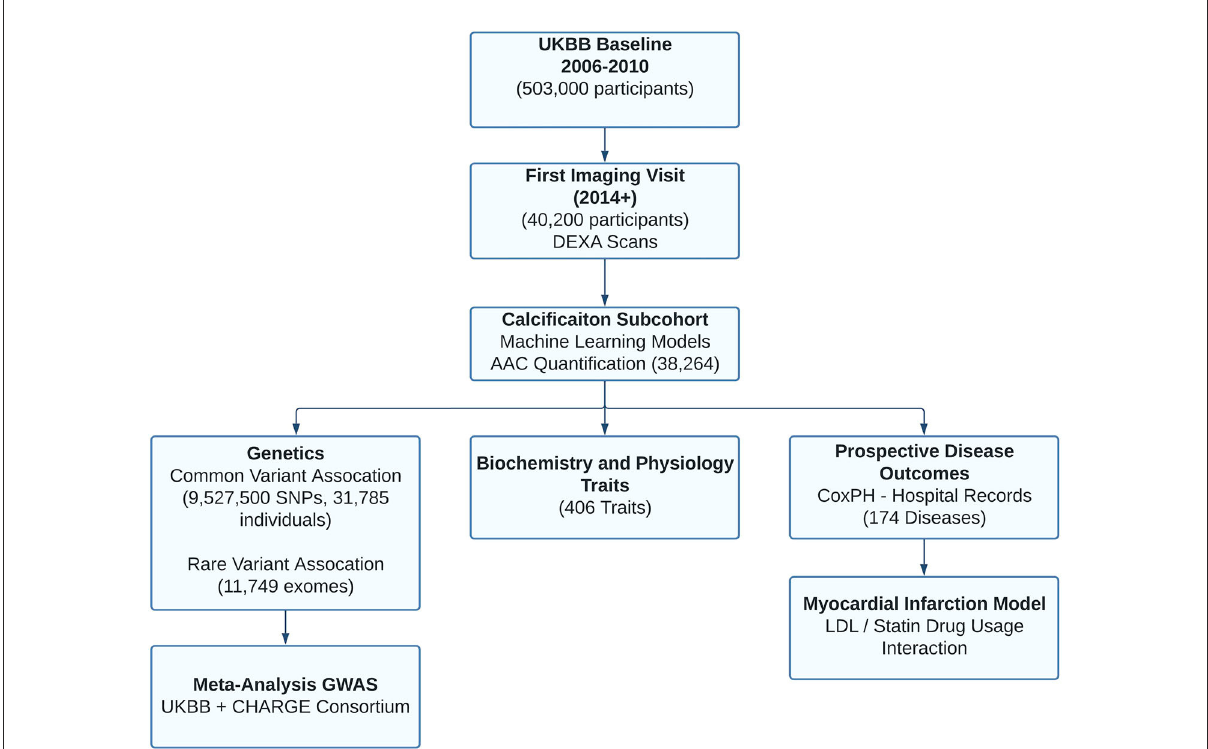
FIGURE1 Overview of analysis and study population. This study focuses on the subset of ∼ 40K individuals with lateral spine DEXA scans collected during the first imaging visit to UK Biobank. Machine learning algorithms enabled automatic quantification of aortic calcification across the majority of participants ( ∼ 38K). We characterized genetics (GWAS, RVAS, fine mapping, colocalization, genetic correlations), epidemiological, and prospective disease outcomes post-imaging visit. Using statin prescription data and LDL measurements, we further investigate the contribution of AAC as an independent predictor of Myocardial